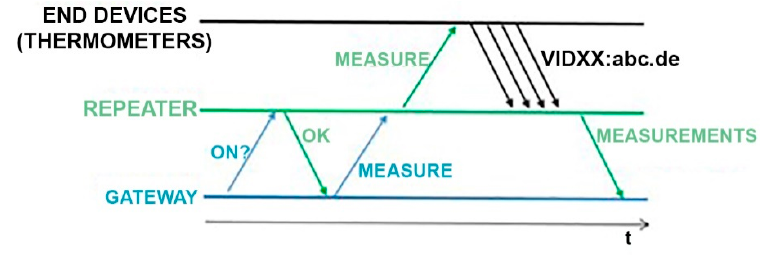
Figure 6. Measurement protocol.